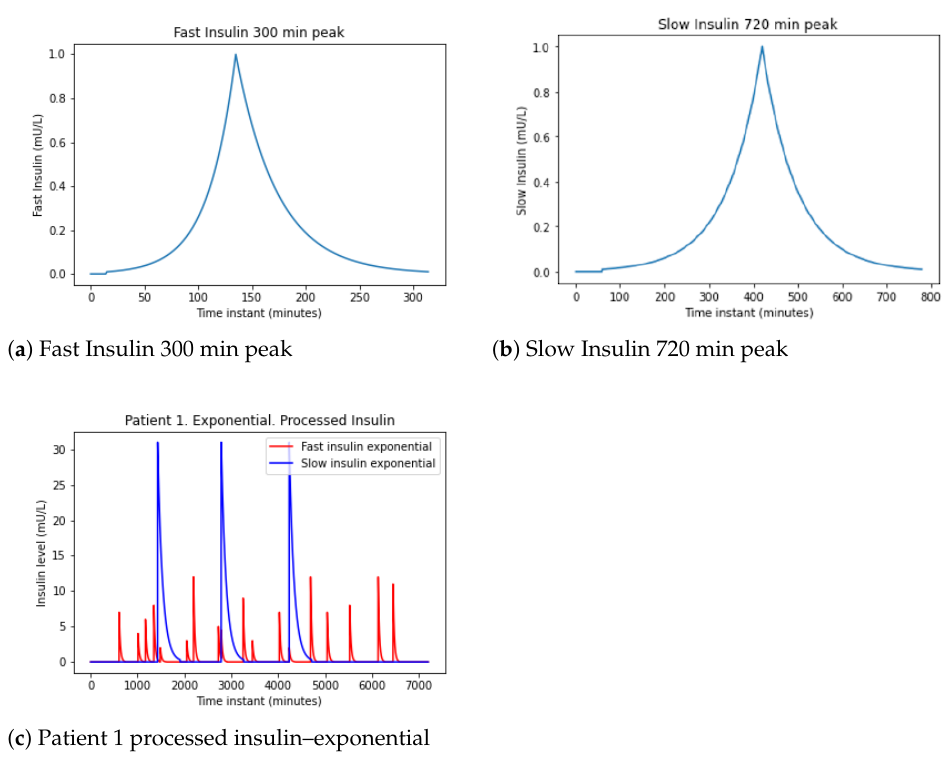
Figure 6. Patient 1 insulin data